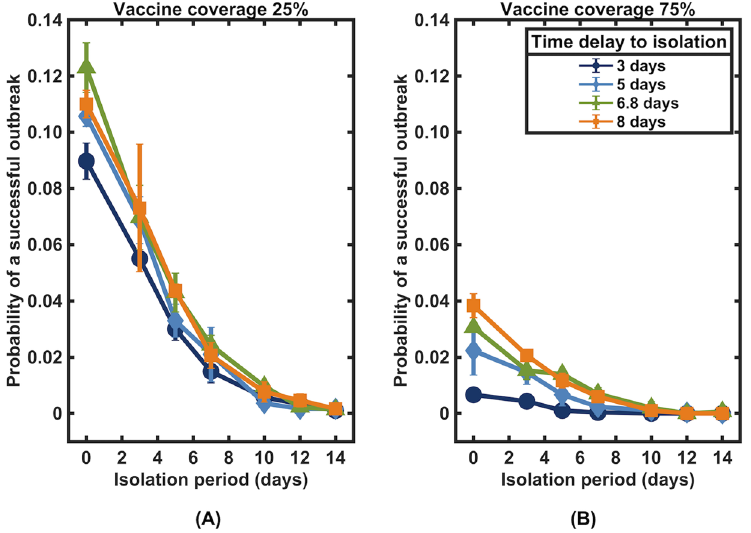
Figure 6. Impact of time delay from infection to isolation under vaccination coverage levels of ( A ) 25% and ( B ) 75%.